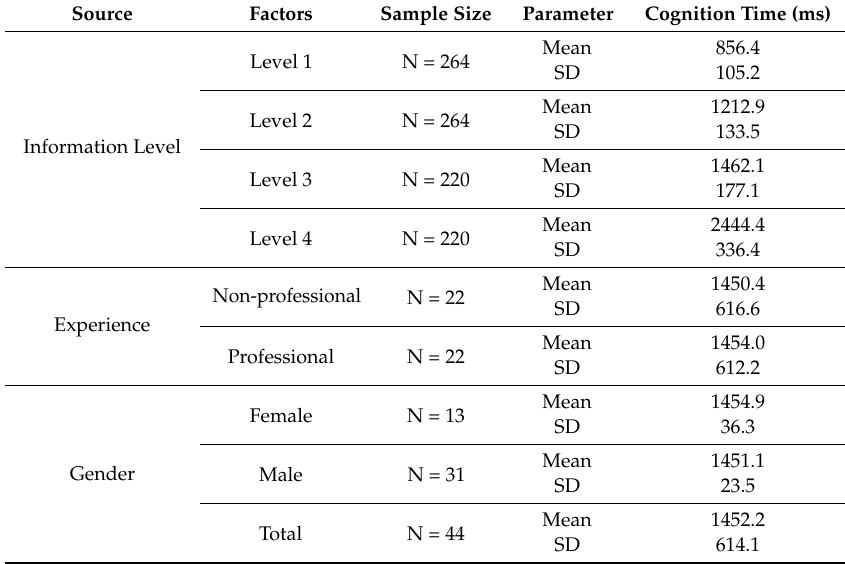
Table 2. Descriptive statistical results for reaction time.